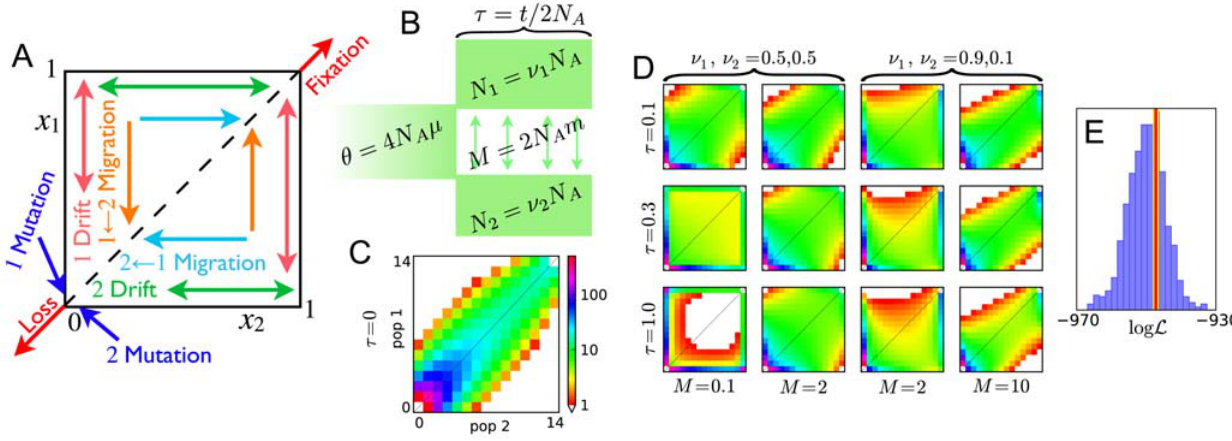
Figure 1. Frequency spectrum gallery. (A) Qualitative effects of modeled neutral genetic forces on w ( x 1 , x 2 , t ) , the density of alleles at relative frequencies x 1 and x 2 in populations 1 and 2. (B) For the spectra shown, an equilibrium population of effective size N A diverges into two populations 2 N A t generations ago. Populations 1 and 2 have effective sizes n 1 N A and n 2 N A , respectively. Migration is symmetric at m ~ M = (2 N A ) per generation, and h ~ 1000 . (C) The AFS at t ~ 0 . Each entry is colored by the logarithm of the number of sites in it, according to the scale shown. (D) The AFS at various times for various demographic parameters, on the same scale as (B). (E) Comparison between coalescent- and diffusion-based estimates of the likelihood L of data generated under the model (A). Coalescent-based estimates of the likelihood, each of which took approximately 7.0 seconds, are represented in the histogram. The result from our diffusion approach, which took 2.0 seconds, is represented by the red line. For accuracy comparison, the yellow line indicates the likelihood inferred from 10 8 coalescent simulations.